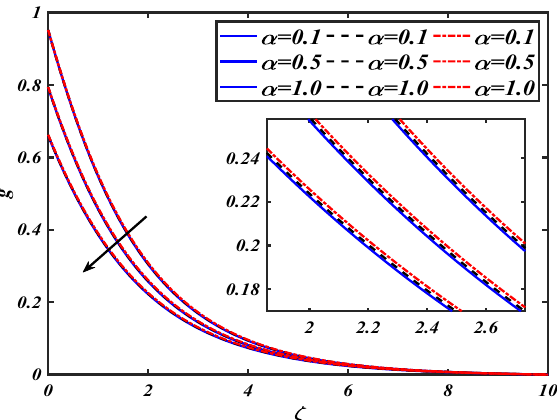
Figure 8. Pictogram of α via g .